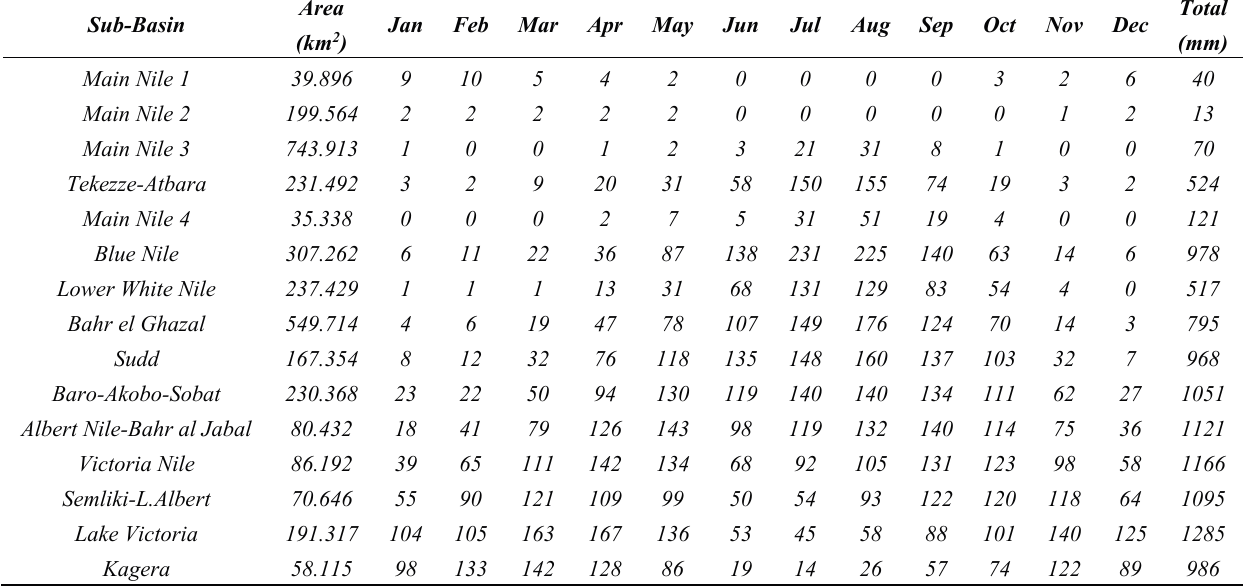
Table 1. Monthly rainfall from the combined TRMM and RFE products averaged for the period 2005–2010 by